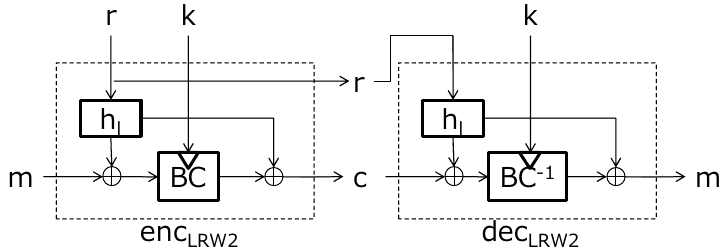
Figure 8. Liskov et al.’s tweakable block cipher: LRW2.